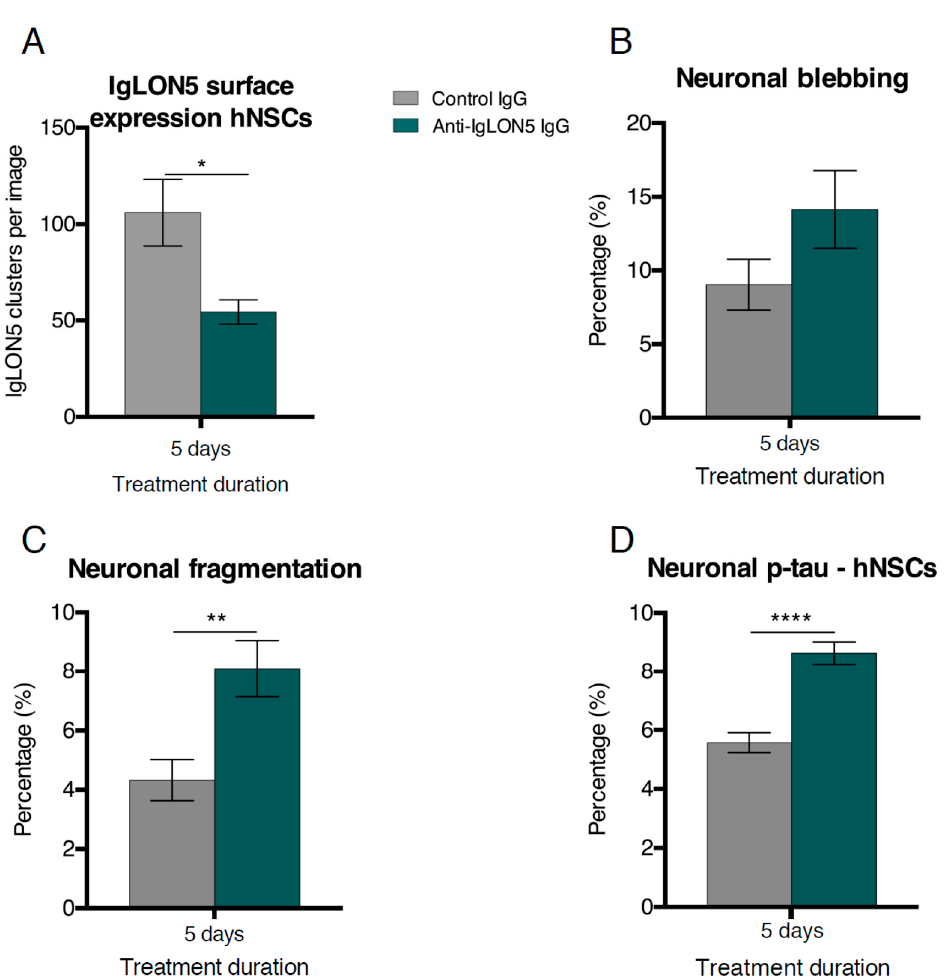
Figure 2. Anti-IgLON5 antibodies cause neurodegenerative changes in human neural stem cell derived (hNSC) neural cultures. Anti-IgLON5 antibodies significantly reduced the number of cell surface IgLON5 clusters ( A ) ( n = 6). When evaluating degenerative changes in hNSC-derived cells after 5 days of antibody exposure, there was a tendency toward increased neuronal blebbing ( B ) ( n = 18–19) when comparing anti-IgLON5 IgG to control IgG. There was also a significant difference in fragmented processes ( C ) ( n = 18–19) between anti-IgLON5 IgG and Control IgG-treated groups. Cultures treated with anti-IgLON5 IgG showed an increase in the percentage of neurons with phosphorylated-tau (p-tau) (T205) when compared to cultures exposed to control IgG ( D ) ( n = 18–19). Statistical method: two-tailed unpaired t -tests (* p < 0.05; ** p < 0.01; **** p < 0.0001).